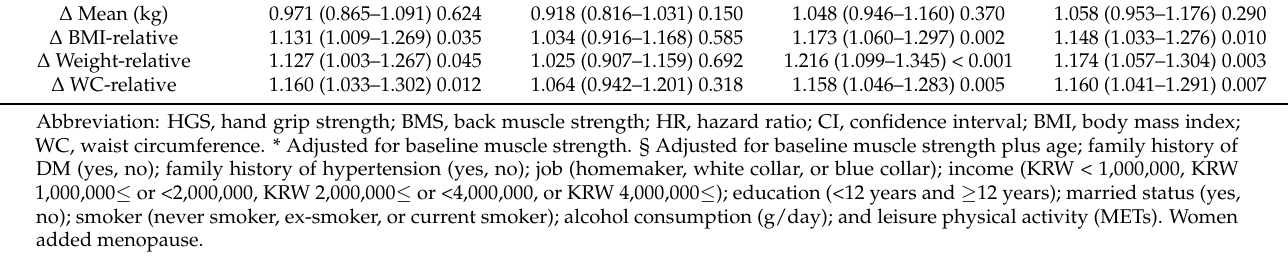
Table 5. Adjusted hazard ratio (HR) of incident metabolic syndrome associated with quintiles group of mean hand grip strength, back muscle strength, and relative muscle strength according to